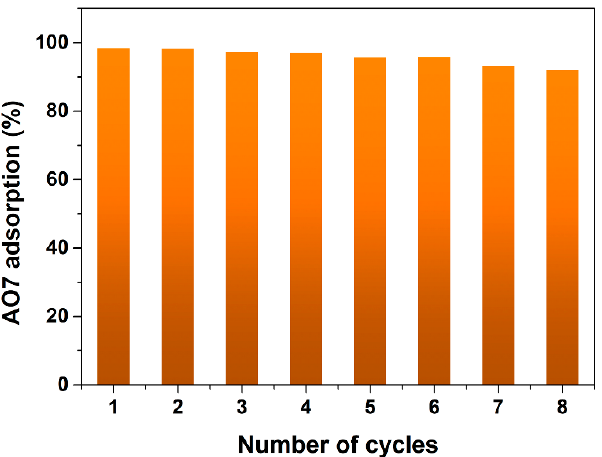
Figure 6. Adsorption histogram in successive adsorption–desorption cycles eight times. (Sample: mesoporous CeO 2 powders synthesized hydrothermally at 140 °C for 24 h with 10 mL H 2 O 2 ; desorbing agents: 20 mL 0.5 mol/L NaOH; desorption time: 5 min; room temperature).